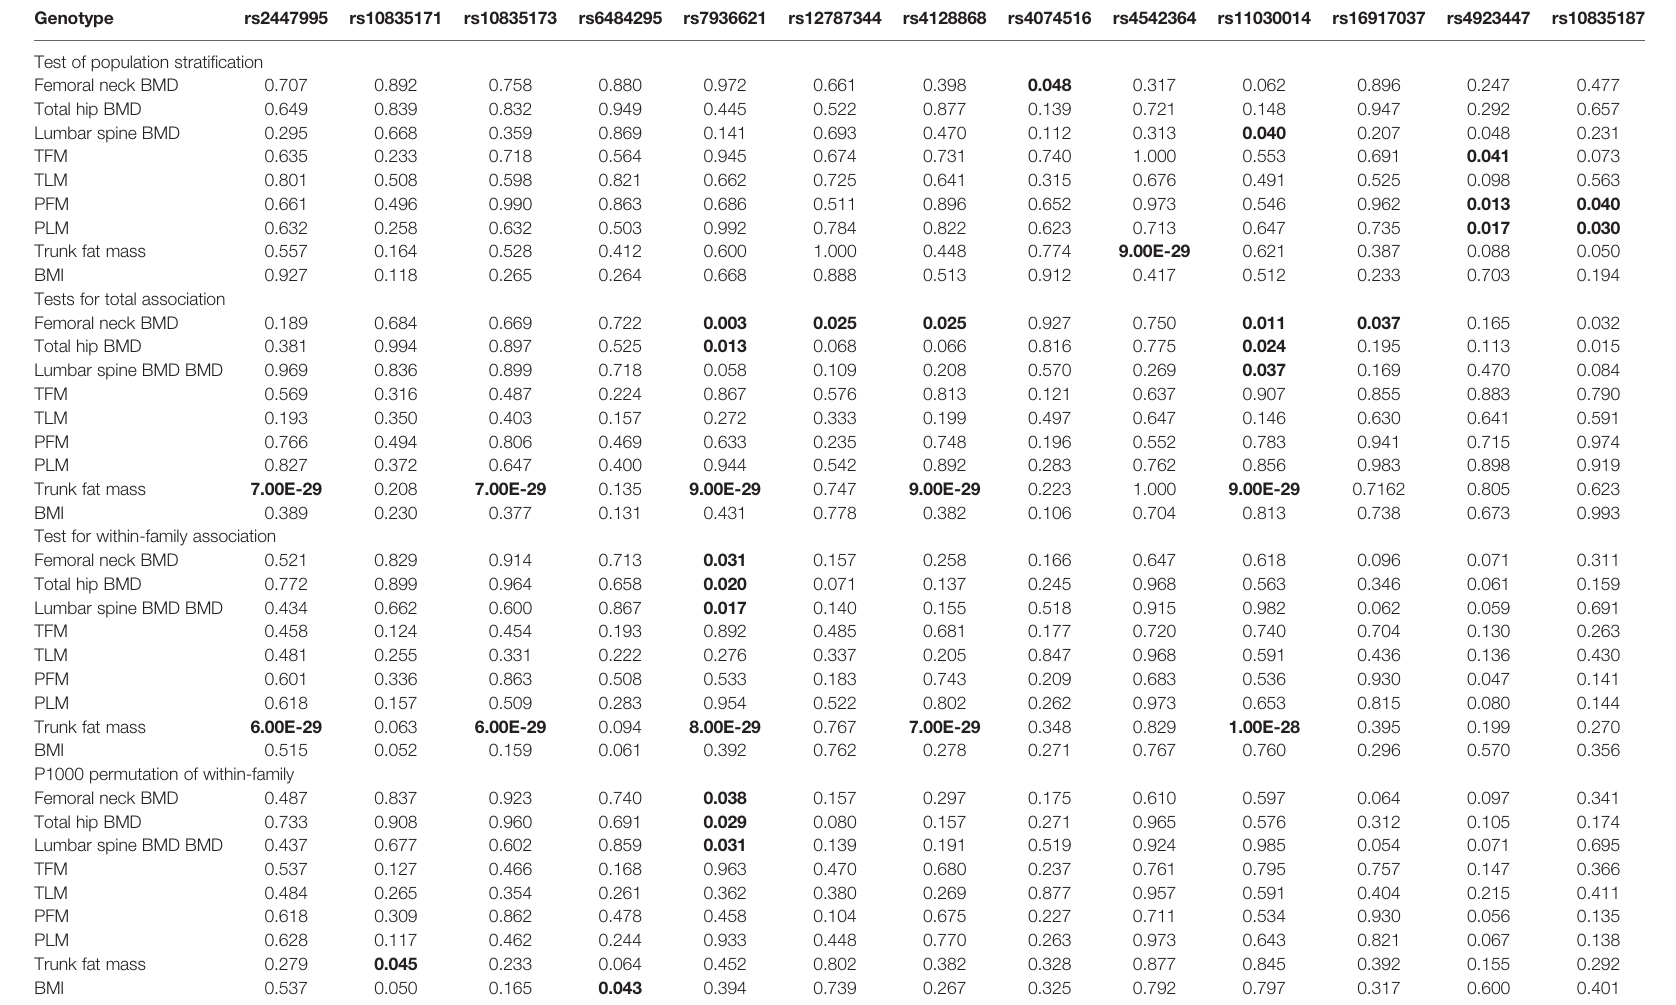
Bold indicates a signi fi cant P-value